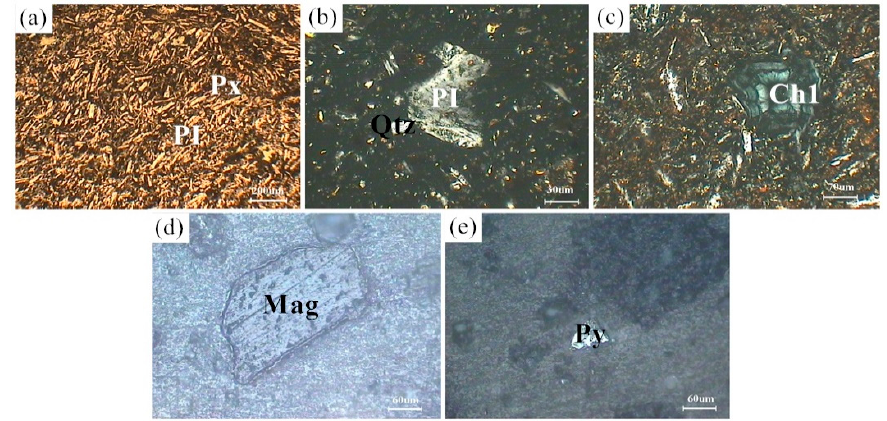
Figure 2. Microscopic features of the basalt rocks. ( a ) Px and PI; ( b ) PI and Qtz; ( c ) Ch1; ( d ) Mag; ( e ) Py.